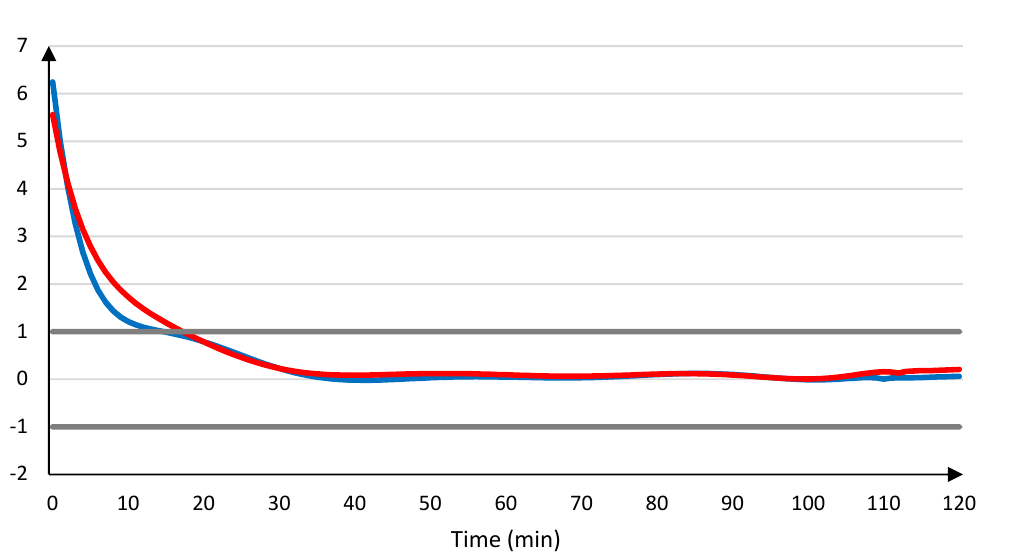
Figure 7. Convergence to the steady state regime (the blue line indicates the enhanced panel and the red one the reference case).